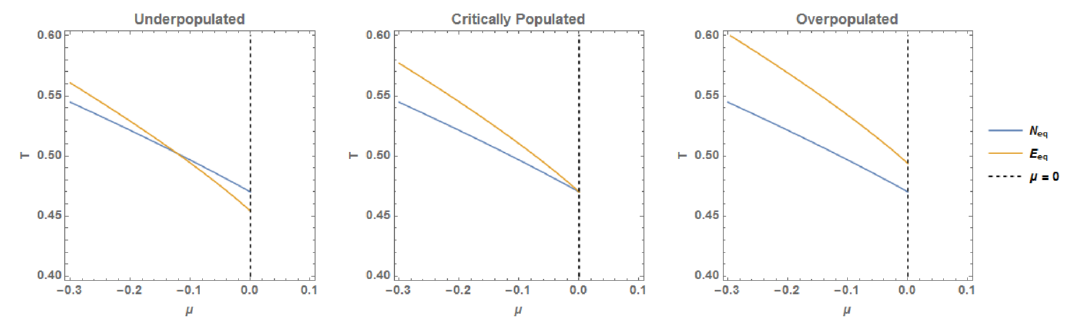
Figure 2. Contours of constant particle number and energy density at equilibrium. The values of the equilibrium parameters T and µ are found where the lines intersect. In the critically populated case, the intersection occurs at the maximum possible value of µ = 0. In the overpopulated case, no real solution for µ < 0 exists and a condensate is necessary to contain the excess